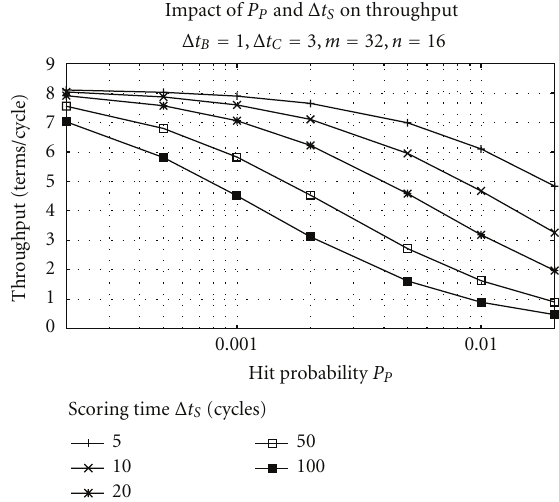
Figure 9: Impact of Bloom filter access time on throughput.